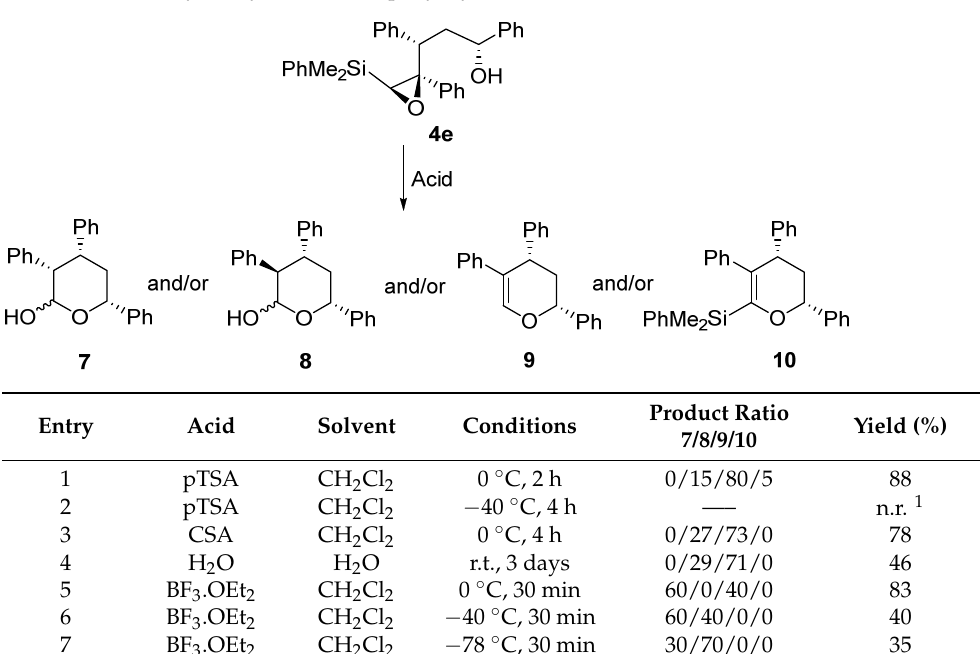
Table 2. Acid catalyzed cyclization of epoxysilyl alcohol 4e .